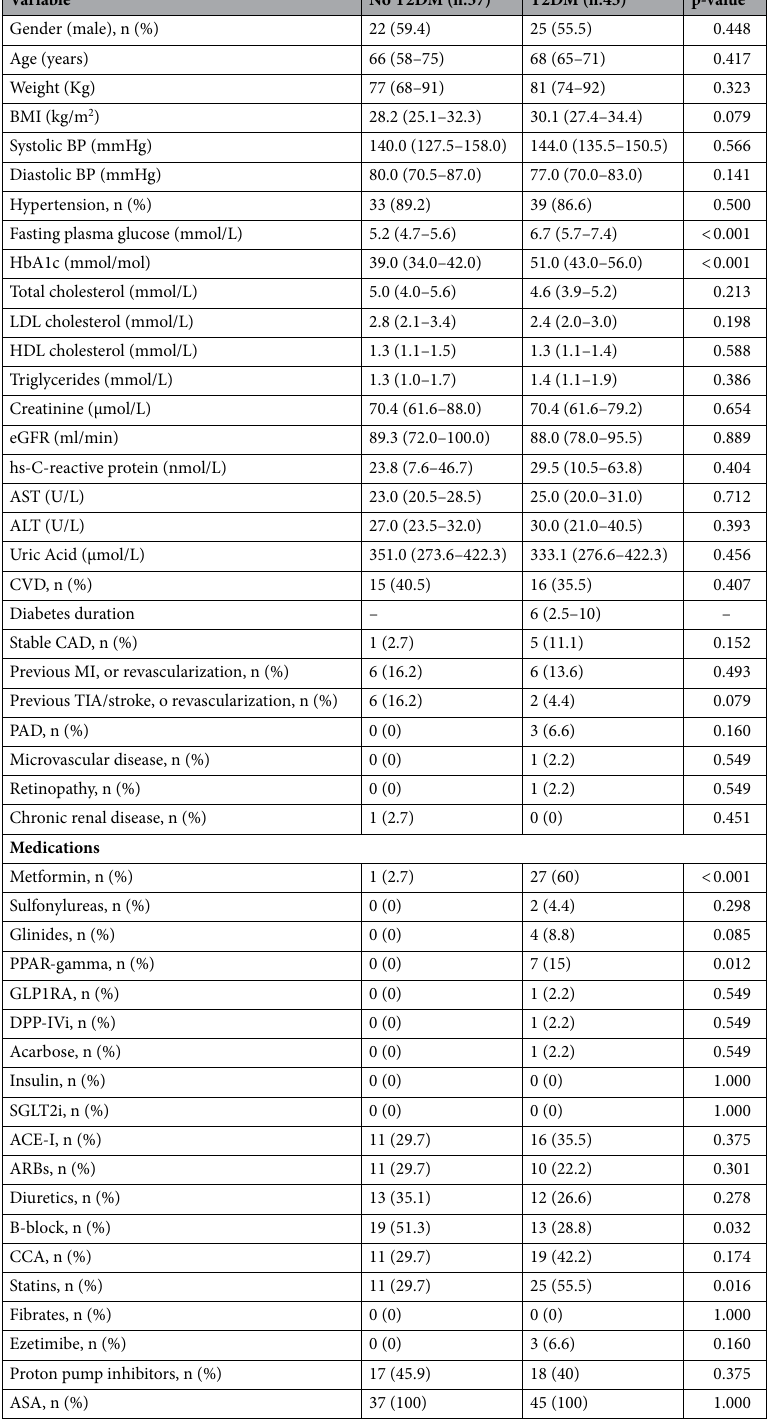
Table 1. Baseline characteristics. Data are median (25th–75th percentile). BMI body mass index, BP blood pressure, CVD cardiovascular disease, MI myocardial infarction, TIA transient ischemic attack, PAD peripheral artery disease, ACE-I ACE-inhibitors, ARBs angiotensin receptor blockers, B-block beta-blockers, CCA calcium channel antagonists, ASA acetylsalicylic acid. a Determined by Mann–Whitney or x 2 test, as